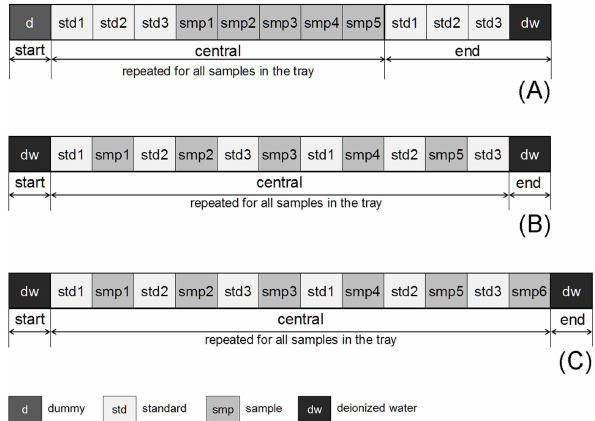
Fig. 1. Schematic representation of vial arrangement in the tray according to the different analytic